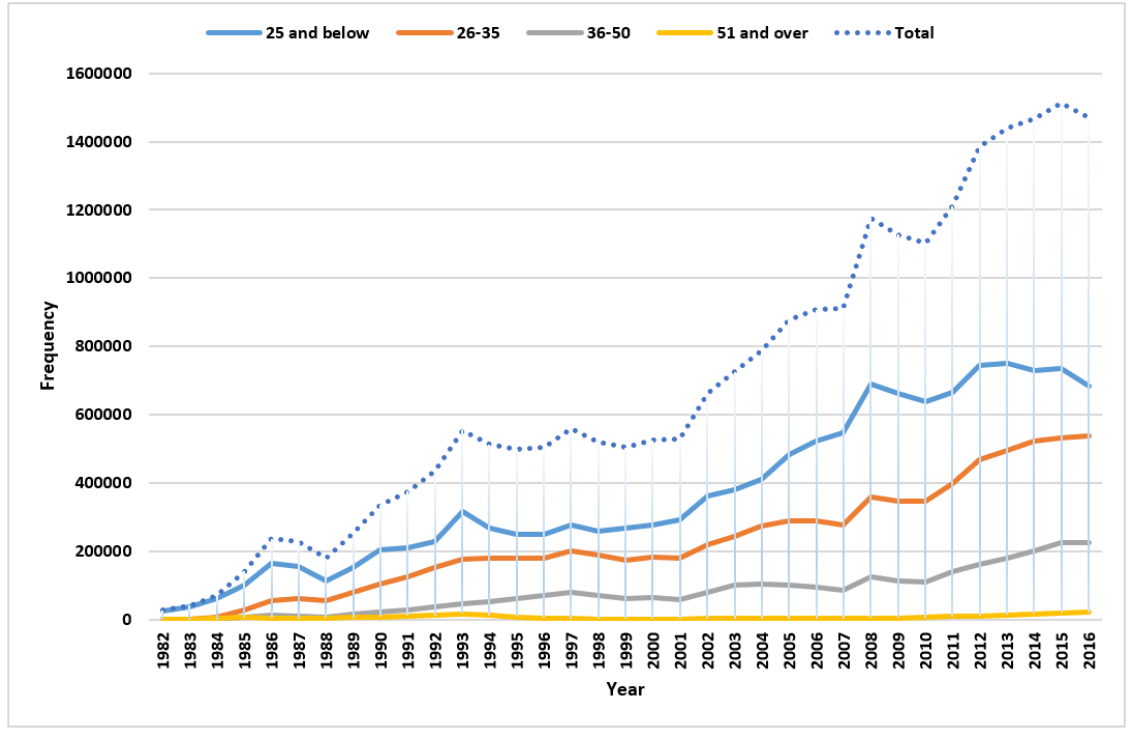
Figure 4. Distribution of age at Anadolu University